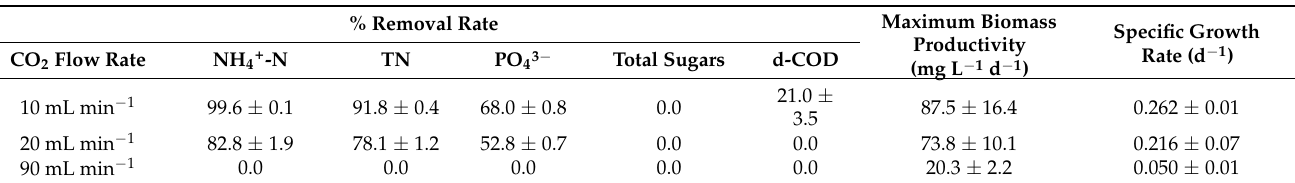
Table 14. Nutrient reduction rates, biomass productivity and specific growth rates in the experimental sets using pure CO 2 as carbon